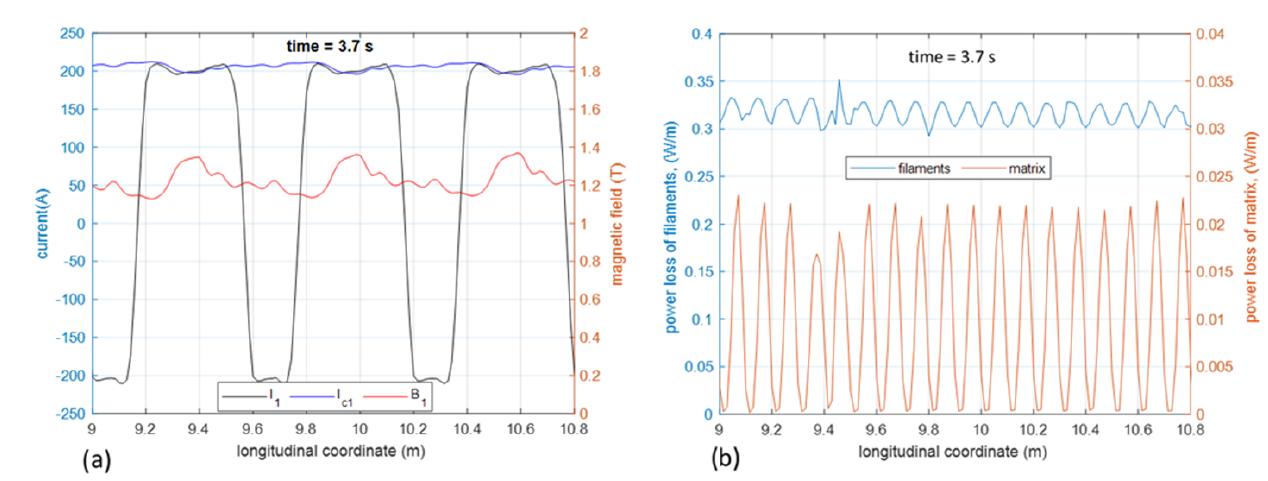
Figure 10. ( a ) Current I 1 and critical current I c 1 of filament 1 over a conductor length of three twist pitches at t = 3.7 s. The magnetic flux density is also shown in the plot. ( b ) Total loss per unit length at t = 3.7 s in the filaments (superconductor and copper) and in the matrix and sheath materials. Two different scales are used for the filament and the matrix loss.